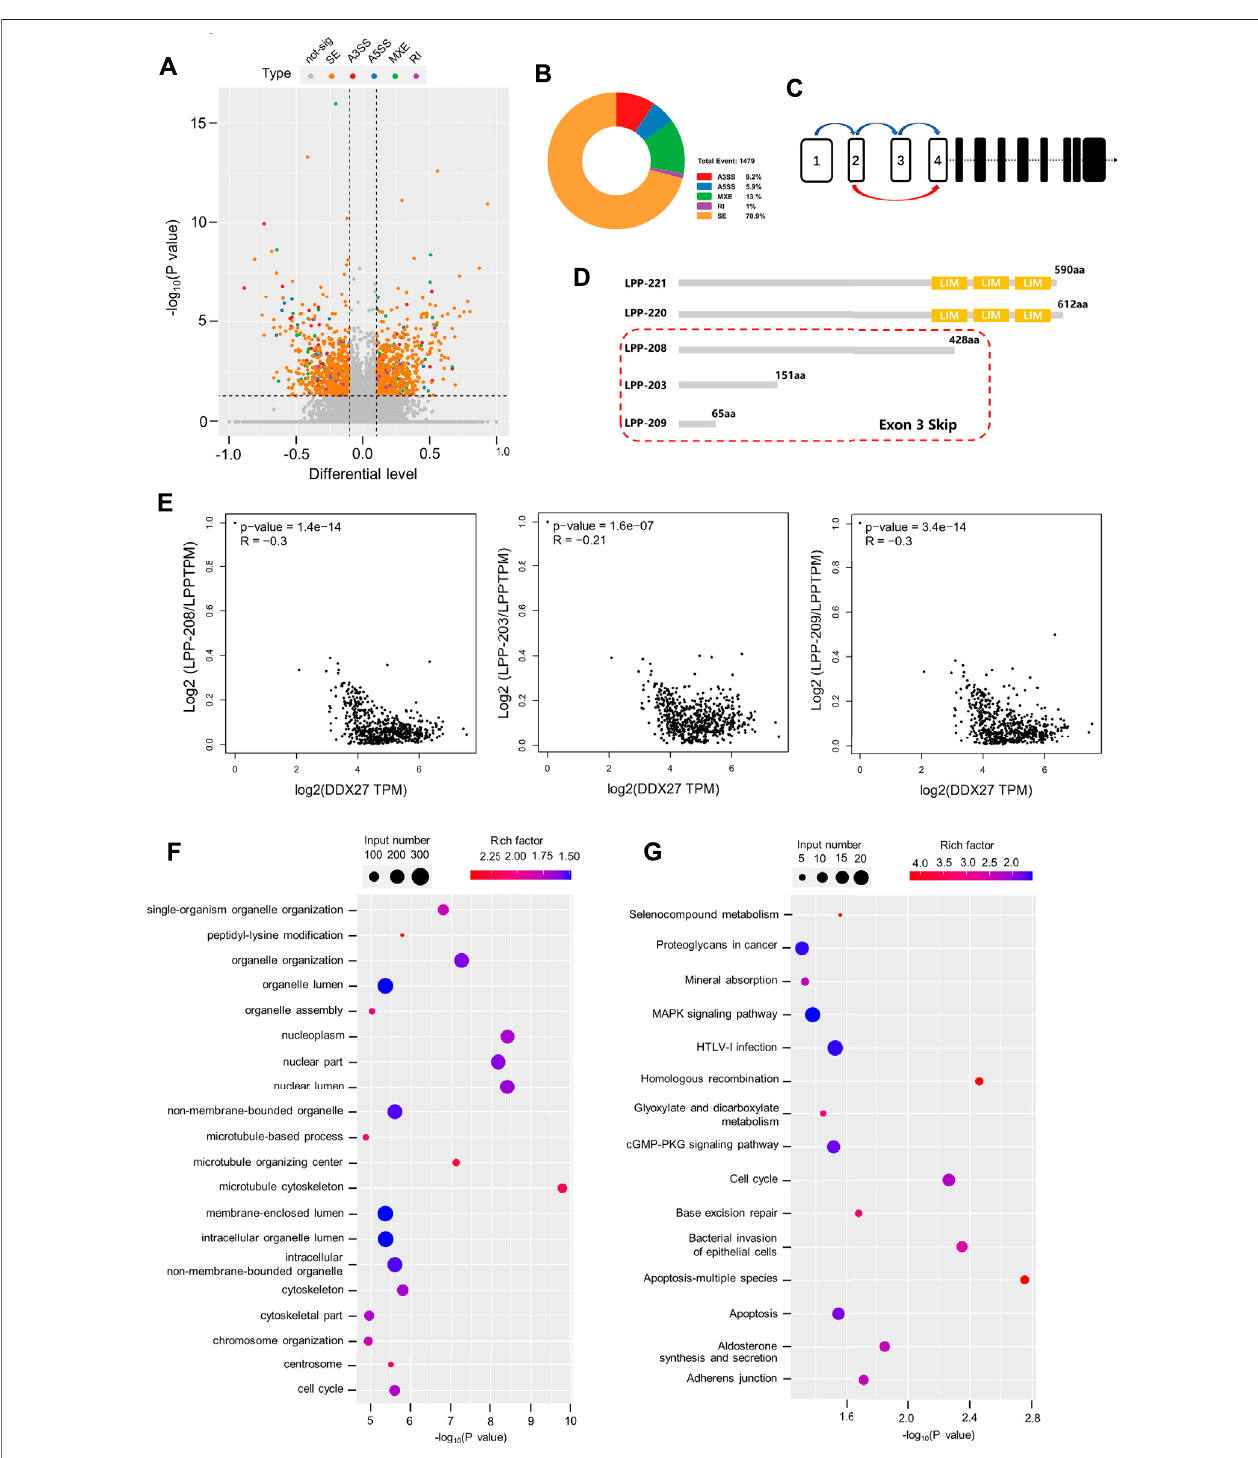
FIGURE 5 | LPP can be regulated by DDX27 through alternative splicing. (A) Volcano plot re fl ects the distribution of 1,169 different alternative splicing genes. ( p < 0.05, difference of alternative splicing events | Δψ | > 0.1). (B) A total of 1,479 alternative splicing events were found in the alternative splicing analysis ( p value < 0.05, | Δψ | > 0.1), ofwhich exon skipping accounted for alargeproportion. (C) Increased exon skipping events in exon 3 of LPP in the gastric cancer cells with DDX27 knockdown. (D) Schematic diagram of the protein domains of several LPP transcript variants. LPP-221 and LPP-220 are the long transcript variants of LPP whose translated proteinshavecompletefunctionaldomains,whileLPP-203,LPP-208,andLPP-209aretranscriptvariantsofexon3skipped,whichlacksthecharacteristicLIMdomain. (E) Spearmancorrelation analysis results ofthe relative expression of LPP transcript variants and DDX27 expression. (Relative expression of LPP transcript variants was normalized with the total LPP). (F,G) GO/KEGG enrichment for different alternative splicing genes. The horizontal axis indicates the signi fi cance of the enrichment (expressed as − log10 ( p value); the vertical axis indicates an enriched GO Terms/KEGG pathway ( p value < 0.05).